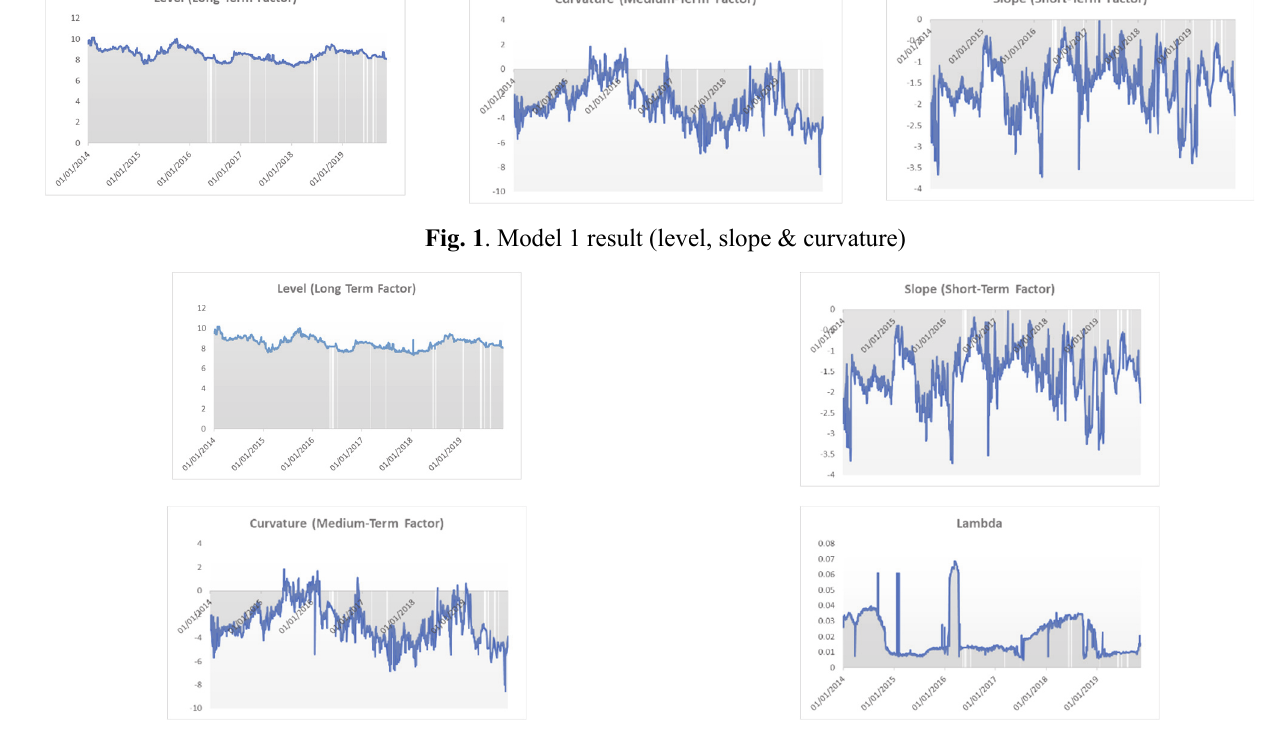
Fig. 2 . Model 2 result (level, slope,